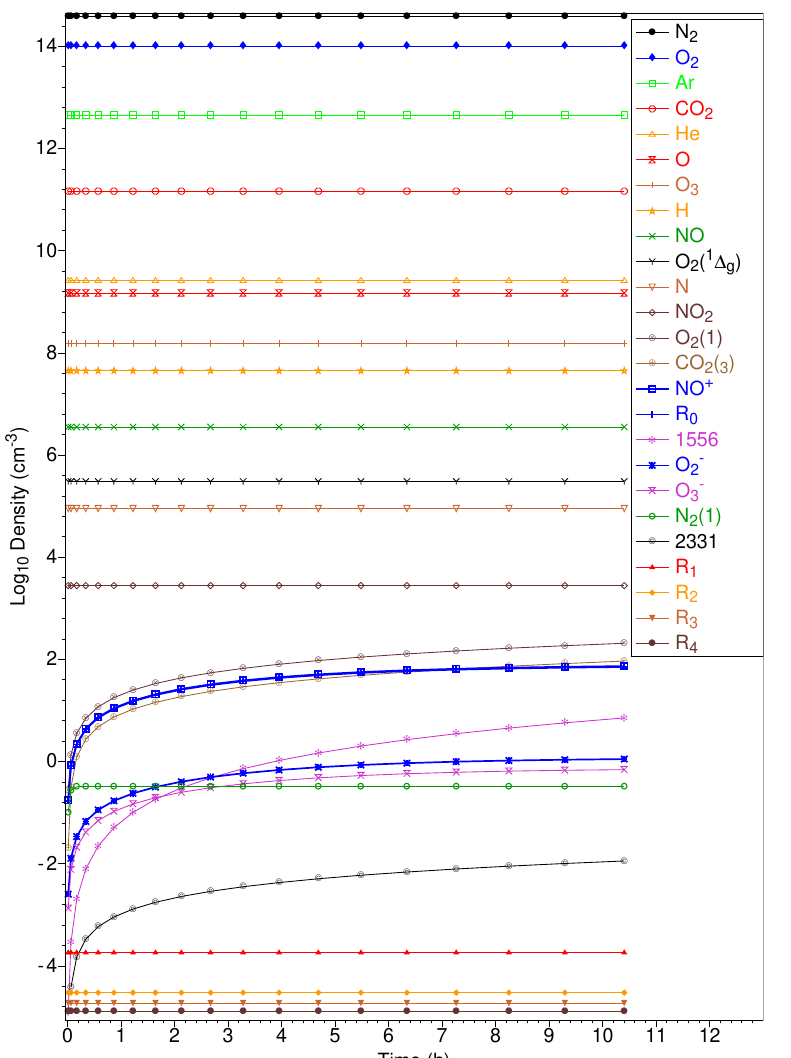
Figure 9. Densities of atmospheric constituents and cumulative emitted photons (as labelled) as a function of time (h) for the EI